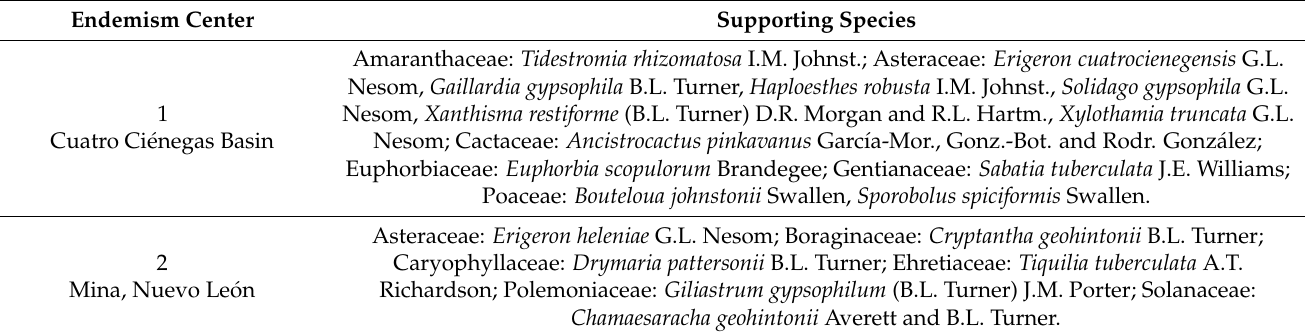
Table 1. Restricted species that support the gypsophyte endemism centers. Endemism Center Supporting